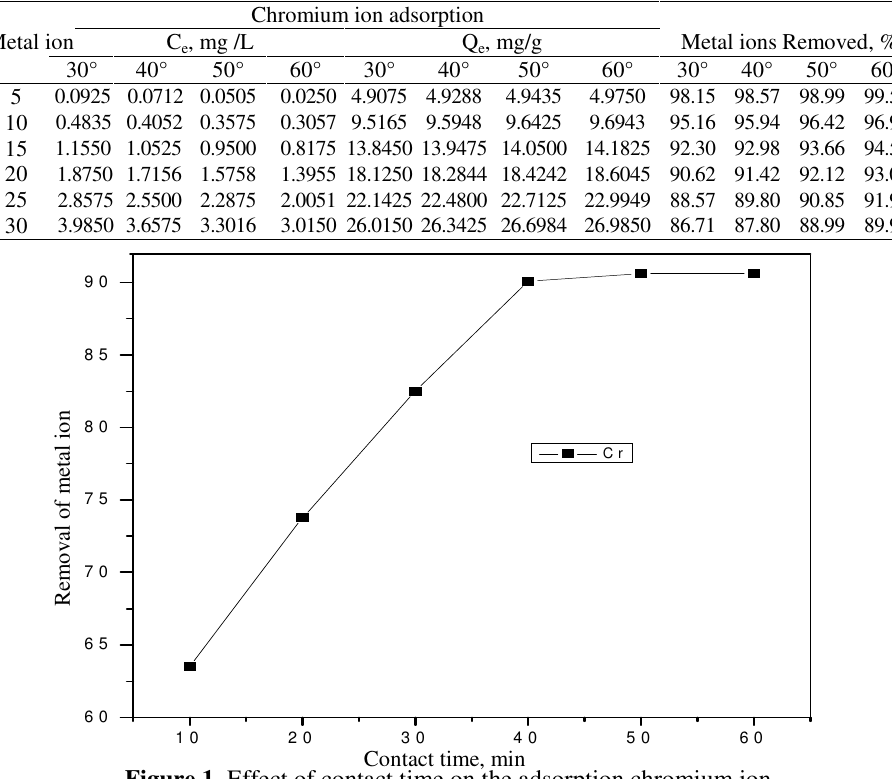
Figure 1. Effect of contact time on the adsorption chromium